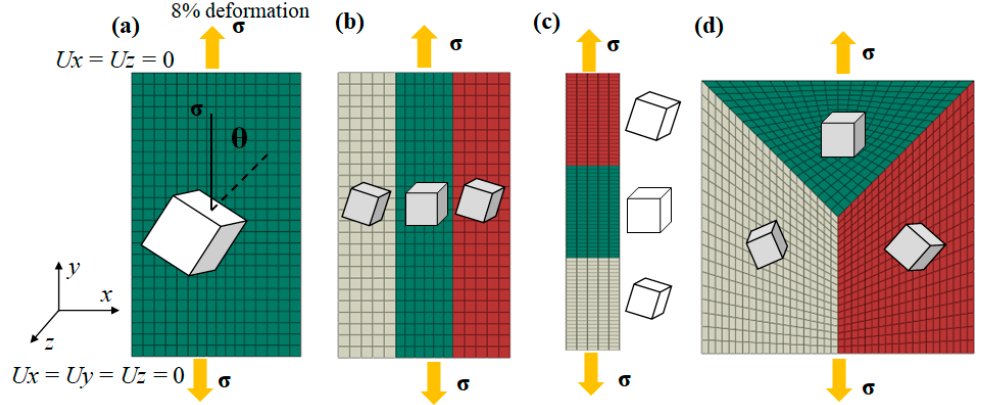
Figure 4. Geometric model and meshes of ( a ) single grains (SGs), ( b ) columnar grains (CGs), ( c ) bamboo-like grains (BLGs), and ( d ) equiaxed grains (EGs).